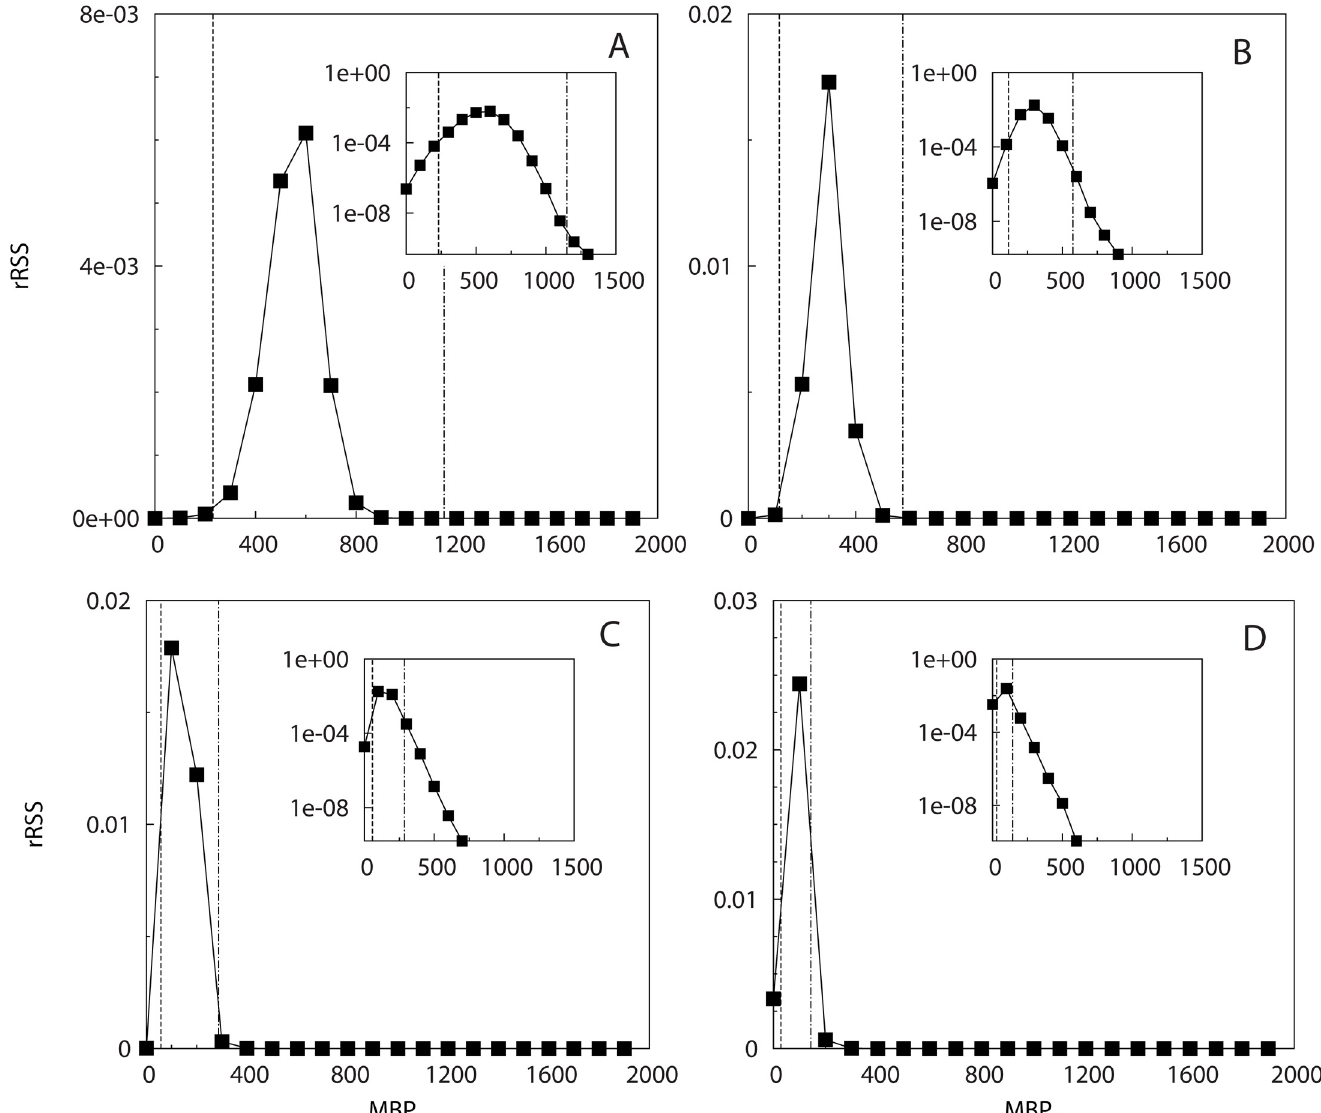
Fig 4. Scenario 2: Renormalized sum of squared residuals. The rSSR is calculated among pairs of survival curves of residence times with Δ MBP = 100 for different model parameters in Eq (4): γ = 0.01 (A), 0.02 (B), 0.04 (C) and 0.08 (D). The vertical lines represent the time values t where μ ( t ) = 1% μ 1 (dashed line) and μ ( t ) = 99% μ 1 (dot-dashed line). Inset: the same in semi-logarithmic